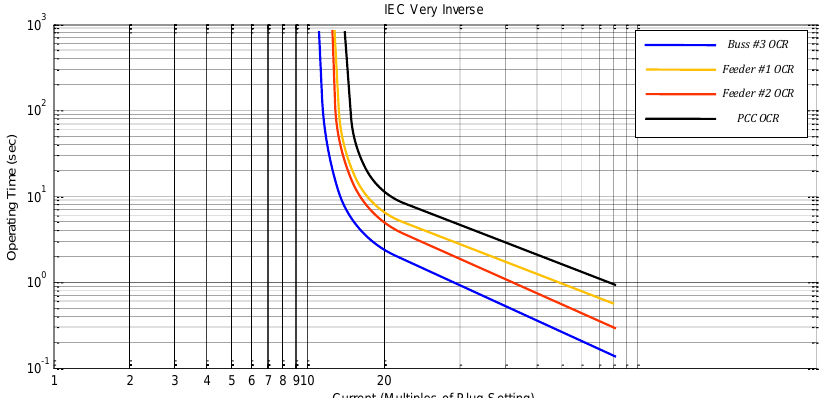
Figure 8. Time-current characteristics of DOCR relays.